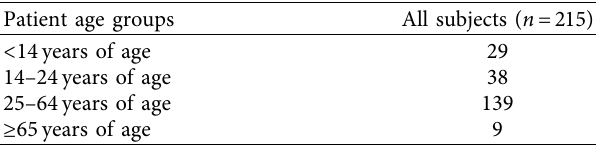
Figure 1: SARS-CoV-2 POC test processing. (a) Schematic diagram of real-time RT-PCR-based SARS-CoV-2 POC test without the need for RNA extraction. (b) Extraction-free technology reduced a normally 6- to 8-step procedure down to a 2-step process. Table 1: Patients’ age distribution.